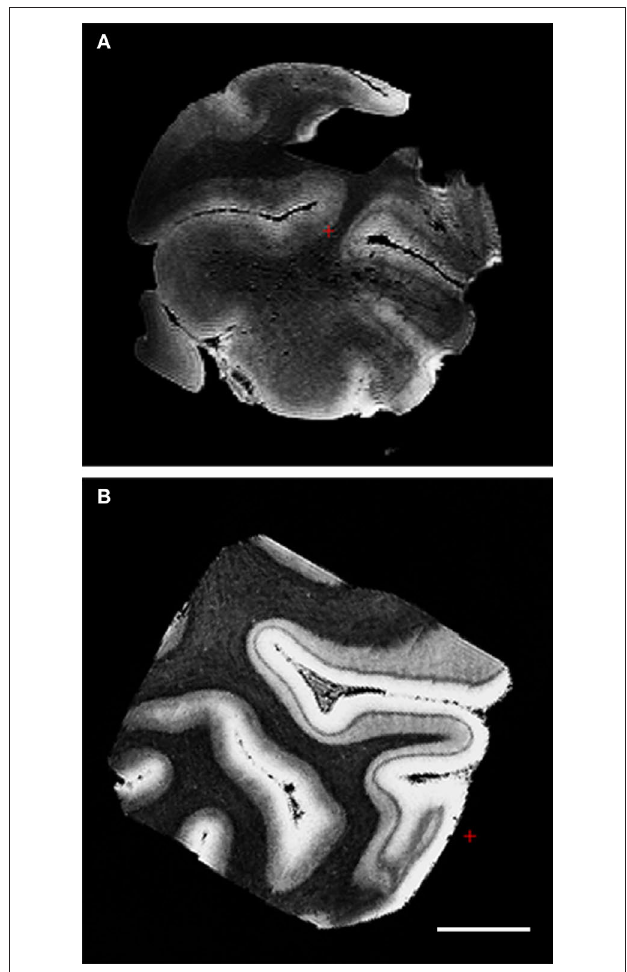
Figure 3 | FLASH images (150 μm) of primary visual cortex tissue unfixed (A) and fixed in formalin (B). Note the line of Gennari in both and the superior CNR in the fixed